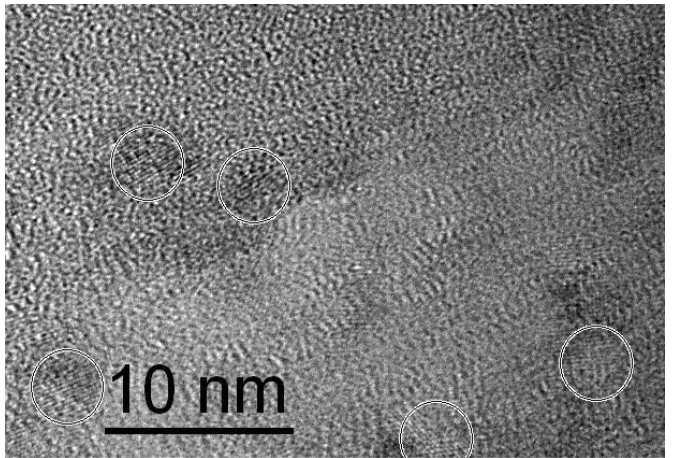
Figure 1. TEM micrograph of titania